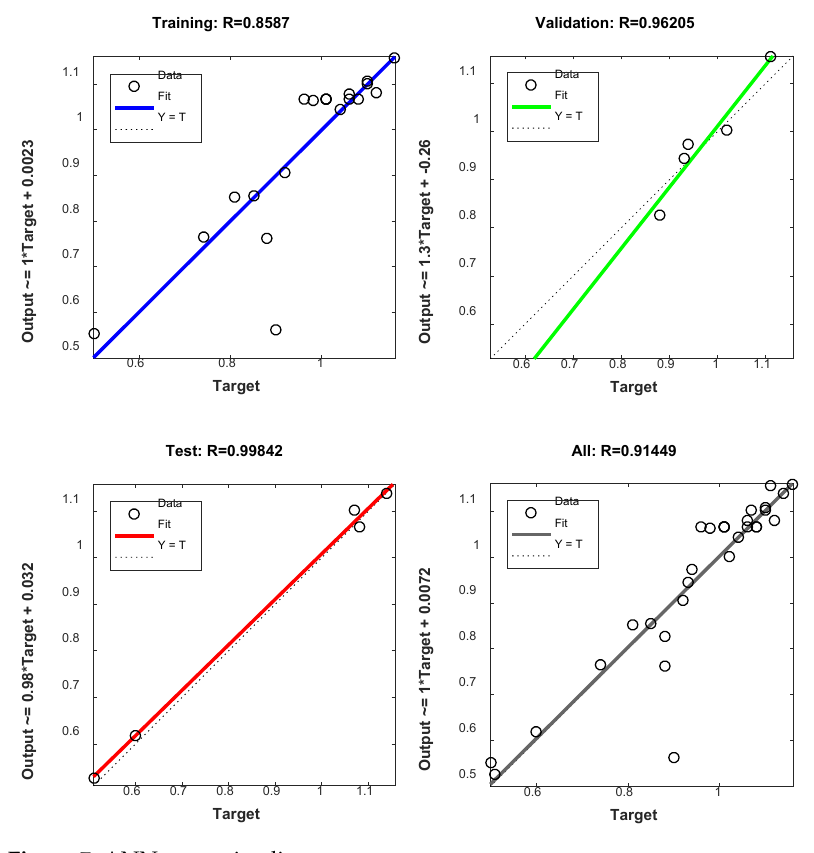
Figure 7. ANN regression line.